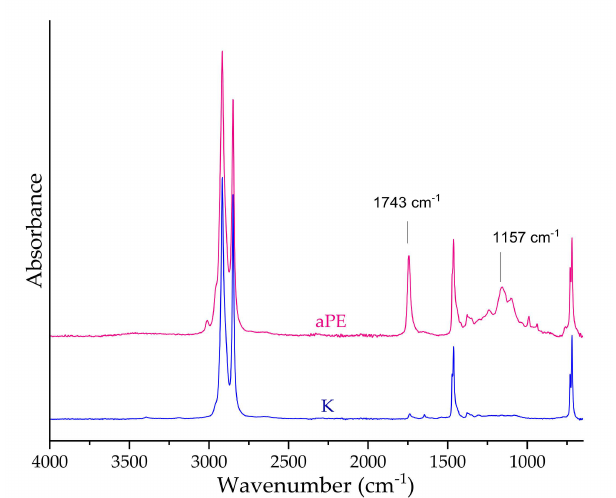
Figure 7. The images of LDPE films. K (blue)—PE control film; aPE (pink)—PE film containing a mixture of CO 2 extracts of raspberry seeds, pomegranate seeds, and rosemary in polymer